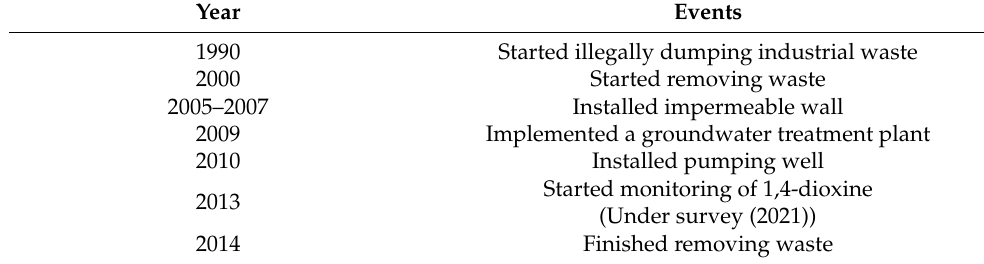
Table 1. History of site modifications (well installation and monitoring period).